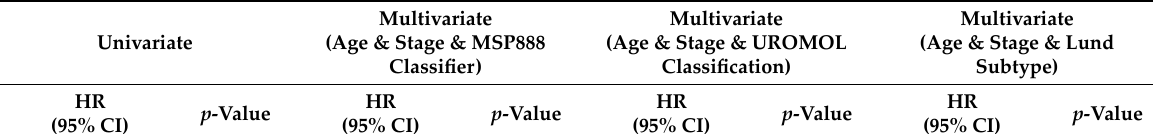
Table 5. Univariate and multivariate Cox regression analysis for predicting progression in the URO‑ MOL